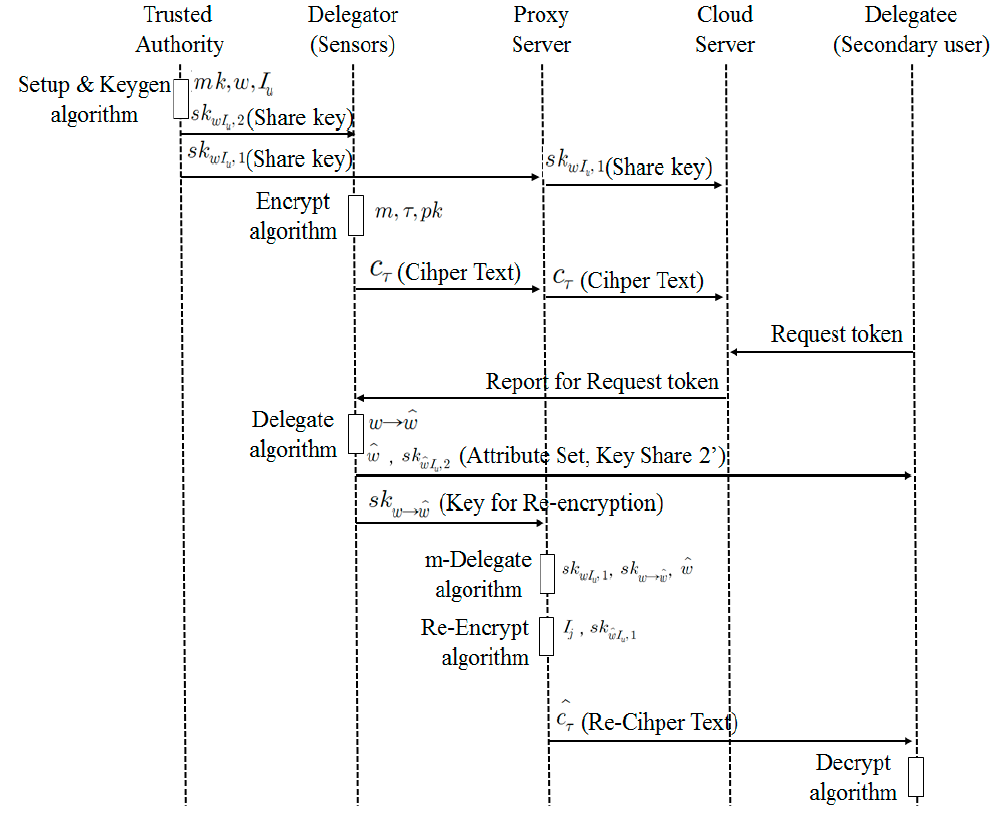
Figure 12. Flow of Communication Control for Access Authority.